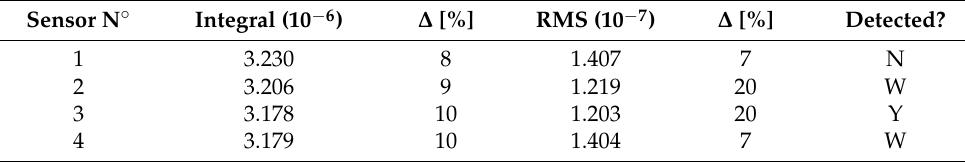
Figure 17. RMS of signal received by each transducer with change of void edge distance from impact point.